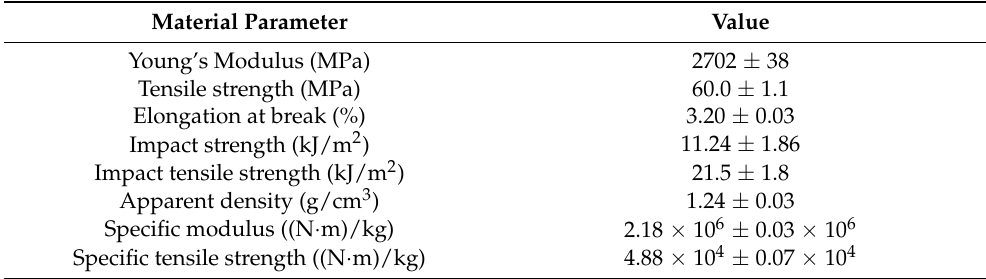
Table 3. The properties of used PLA material.